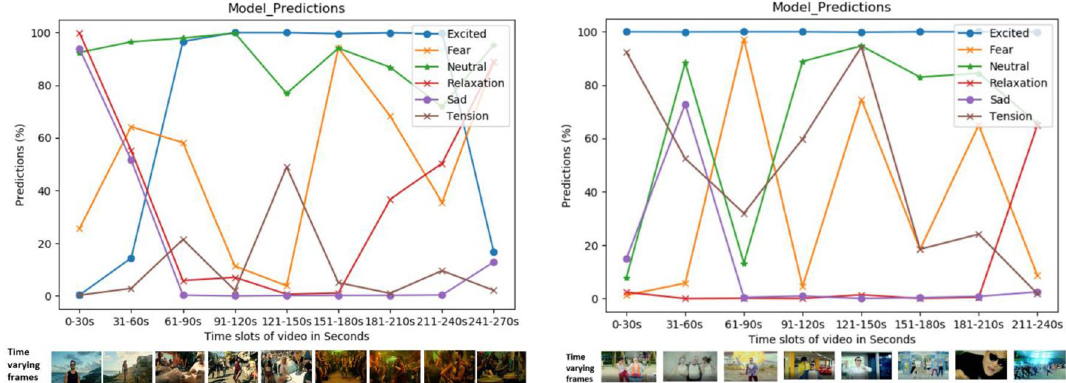
Figure 11. Time synchronized emotion prediction for specific music videos. (Left) prediction result on Luis_ Fonsi and (right) prediction redult on Gangnam Style music video.